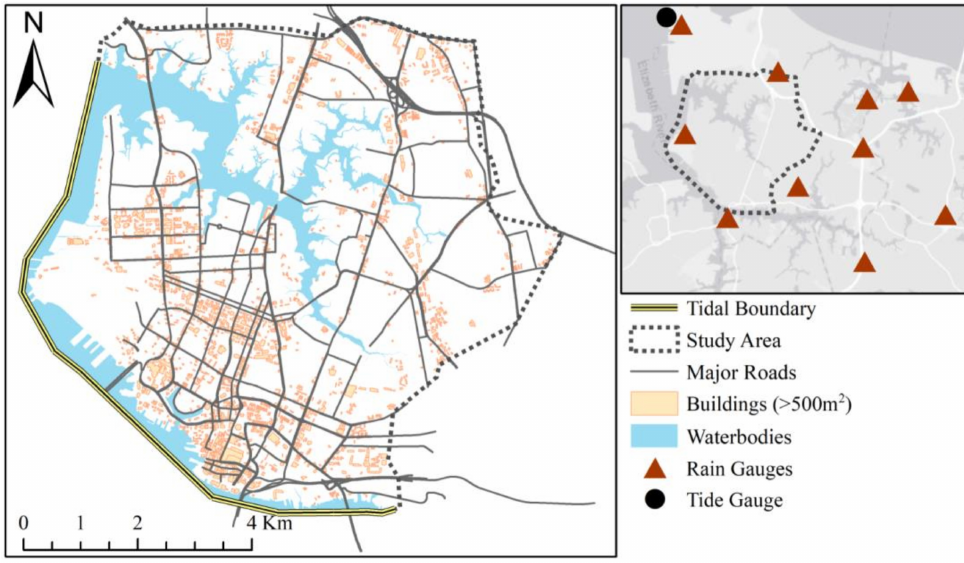
Figure 2. Urban flood model and locations of tide and rain